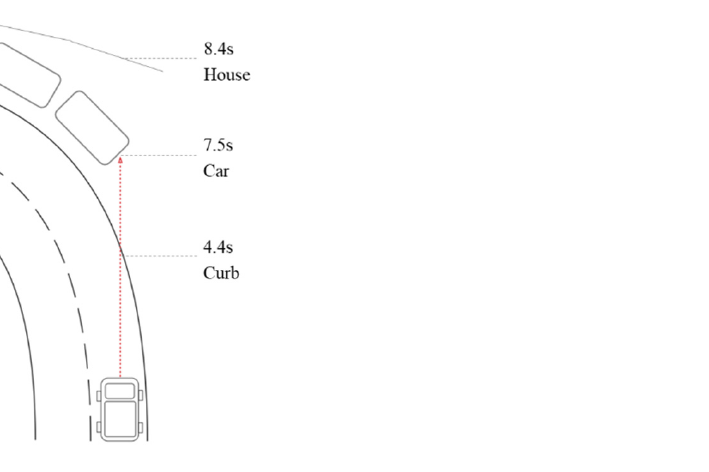
Figure 5. System malfunction scenario with approximate TTC with surrounding elements at the beginning of the lane drift.